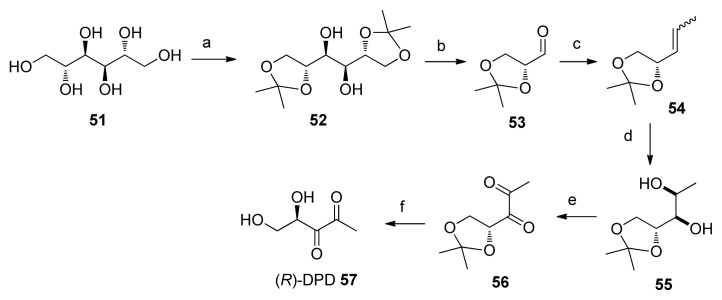
Synthesis of R- and S-DPD by Gardiner and co-workers: (a) 2,2-dimethoxypropane, p-TSA, 57%; (b) NaIO4, NaHCO3, 75%; (c) (ethyl)triphenyl phosphonium bromide, n-BuLi, 70%; (d) 4% OsO4, NMO·H2O, 70%; (e) PCC, 30%; (f) H2O, H2SO4.